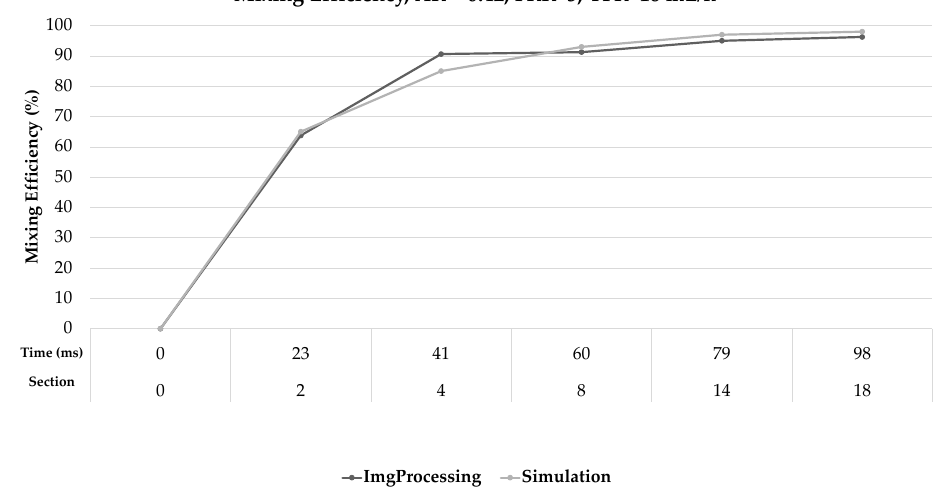
Figure 9. Comparison between simulation results and those obtained in image processing: AR = 0.42, FRR = 3; TFR = 18